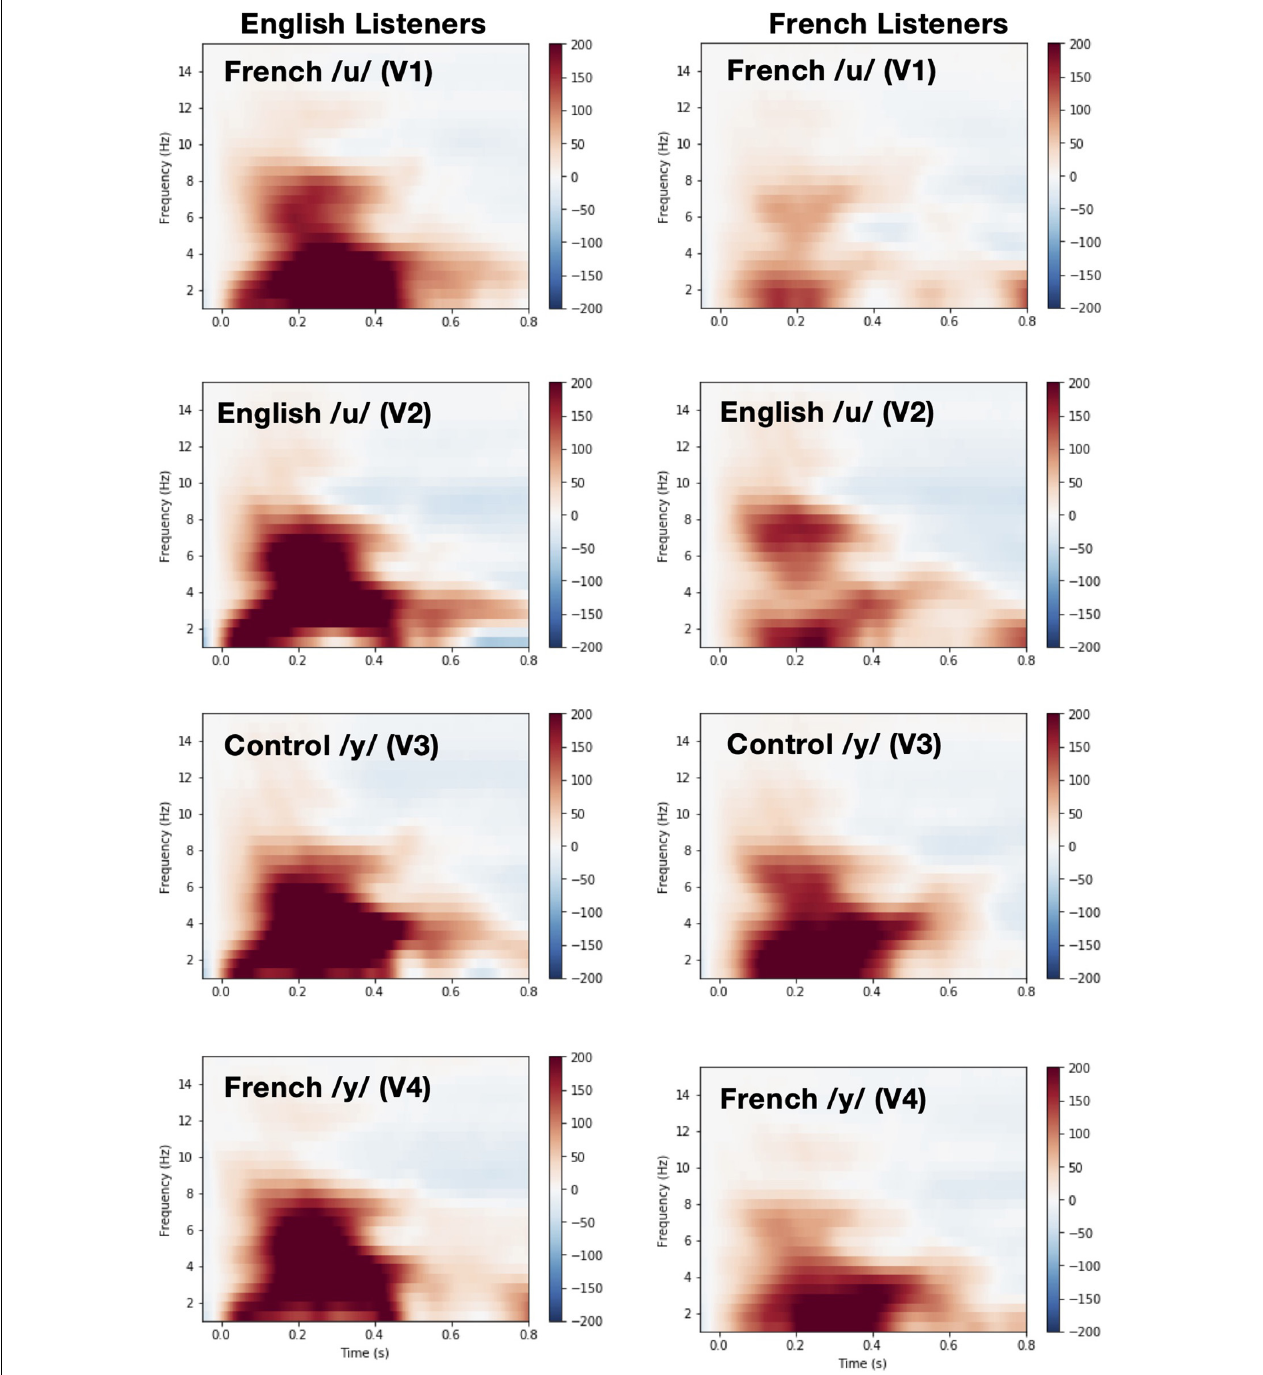
FIGURE 8 | Time-Frequency plots showing brain oscillations for each vowel during pre-deviant standard trials (averaged across the F3, F4, Fz, C3, C4, and Cz electrode sites, 0–600 ms time window and between 4 and 8 Hz) and for each language group [English ( left panel ) vs. French ( right panel